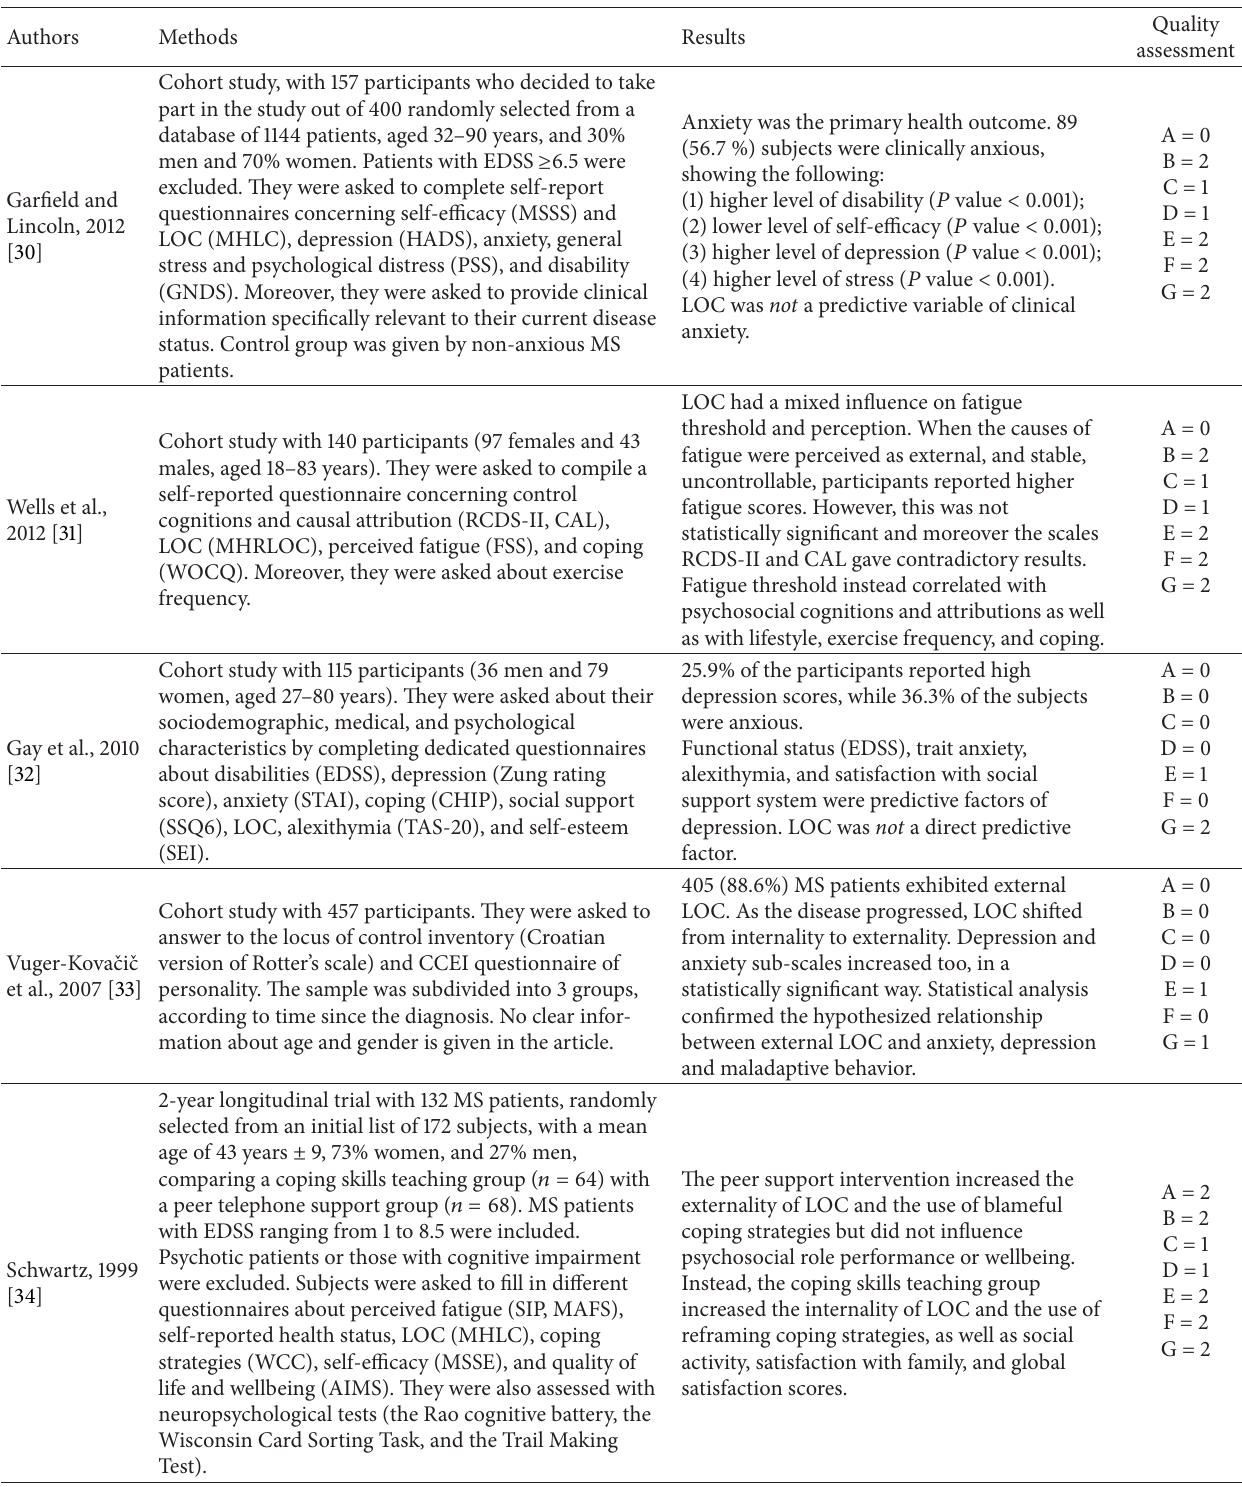
Table 2: All articles collected for the systematic